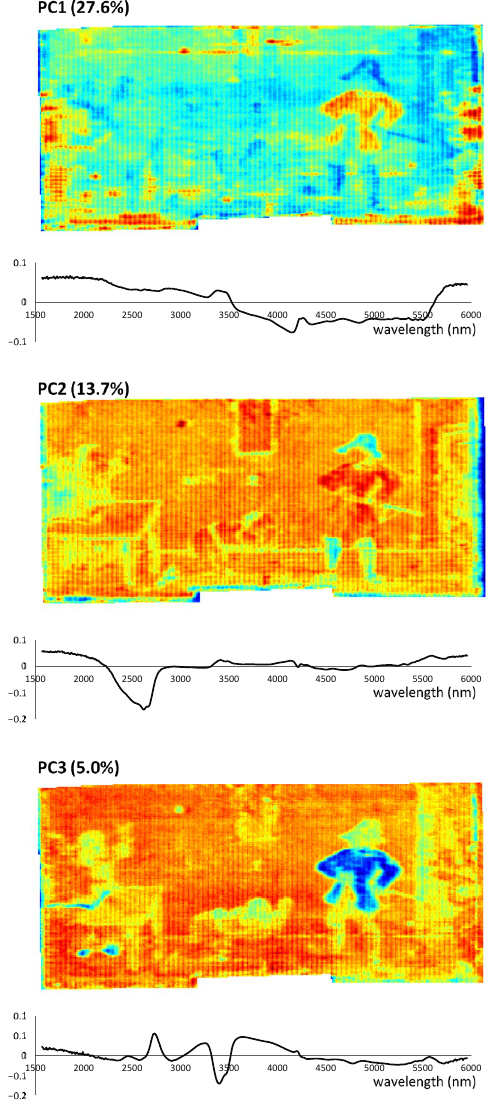
Figure 5. Results of PCA for images taken in the MWIR spectral range. Note: The percentages in parentheses explain the variances of all the individual principal components.